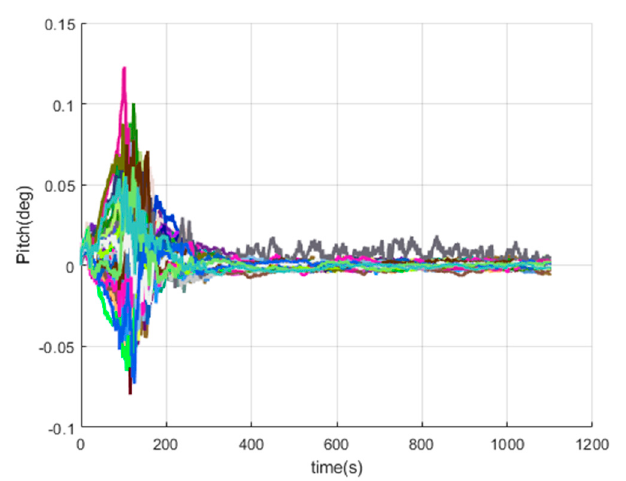
Figure 16. The pitch angle errors of SINS/GPS in the launch-centered Earth-fixed (LCEF) frame.